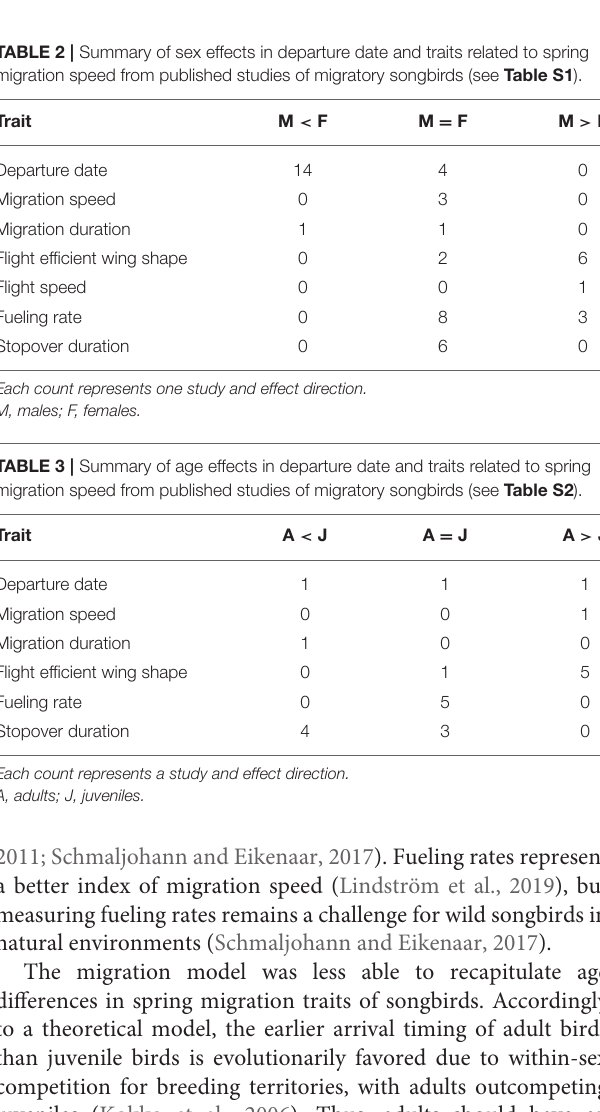
FIGURE 7 | Predictions for the power requirement for flight P arising from randomized simulations of the migration model 2.1. (A) Shows the effect of different combinations of target arrival time τ and migration distance d . (B) Shows the effect of different combinations of target arrival time τ and fueling rate k .